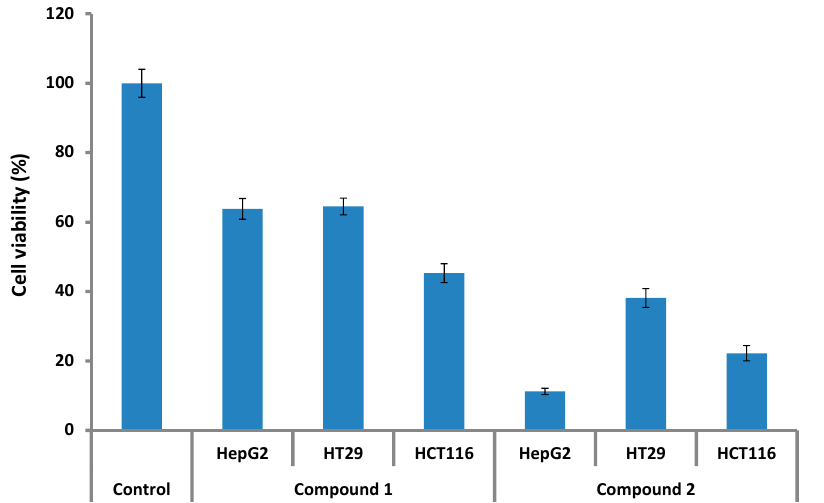
Figure 2. Anticancer cell activity of compounds 1 and 2 . The bars represent the mean values with standard error of three